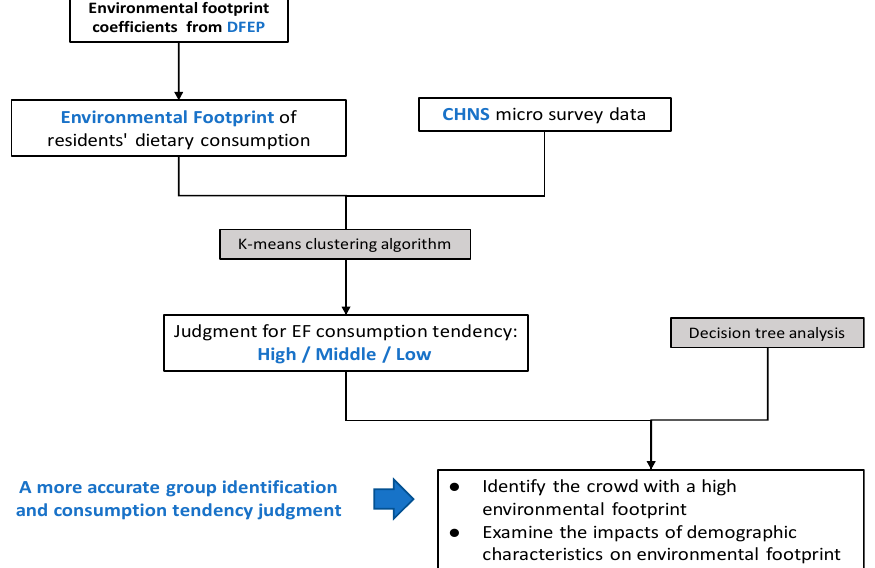
Figure 1. Research framework. Double Food–Environmental Pyramid (DFEP) provides the environmental footprint database; CHNS refers to the China Health and Nutrition Survey.